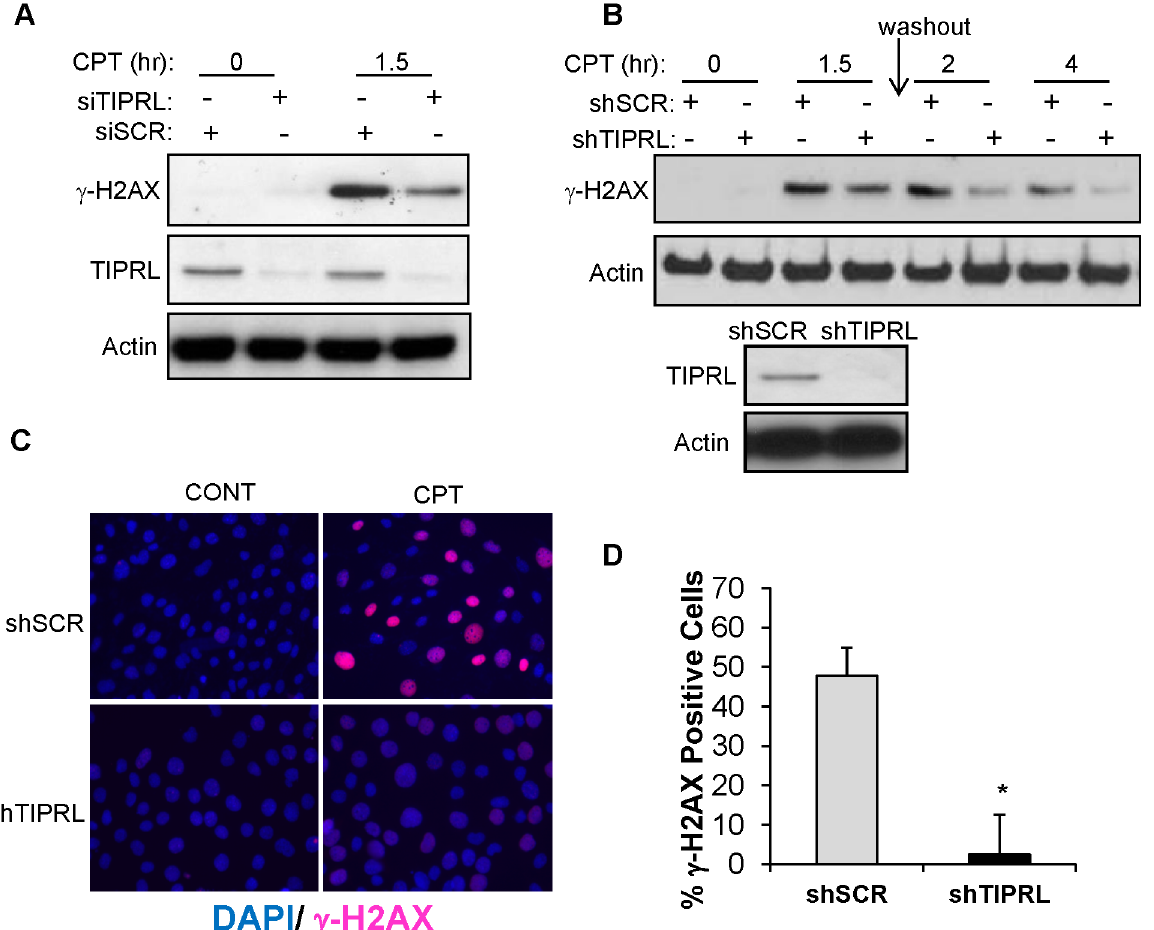
Fig 4. Knockdown of TIPRL inhibits γ -H2AX phosphorylation upon DNA damage. (A) HeLa cells were transfected with a scramble (siSCR) or TIPRL siRNA (siTIPRL). 48hrs after transfection, cells were treated with 2.5 μ M CPT for 1.5hrs. Cell lysates were prepared and immunoblotting was performed using the indicated antibodies. (B) 3T3 MEFs infected with retrovirus containing a short hairpin (sh) against TIPRL (shTIPRL) or scrambled shRNA (shSCR) were treated with 2.5 μ M CPT for 1.5hrs. The drug was washed out of the cells and fresh media was added back for the indicated amount of time. Cell lysates were prepared and immunoblots were probed with the indicated antibodies. (C) 3T3 MEFs expressing a short hairpin (sh) against TIPRL (shTIPRL) or scrambled shRNA (shSCR) were treated with 5 μ M CPT for 1hr and stained with both DAPI and anti- γ -H2AX (D) followed by quantification of the images. Data represent ± standard deviation of the mean of three fields. * p < 0.01, Student ’ s t